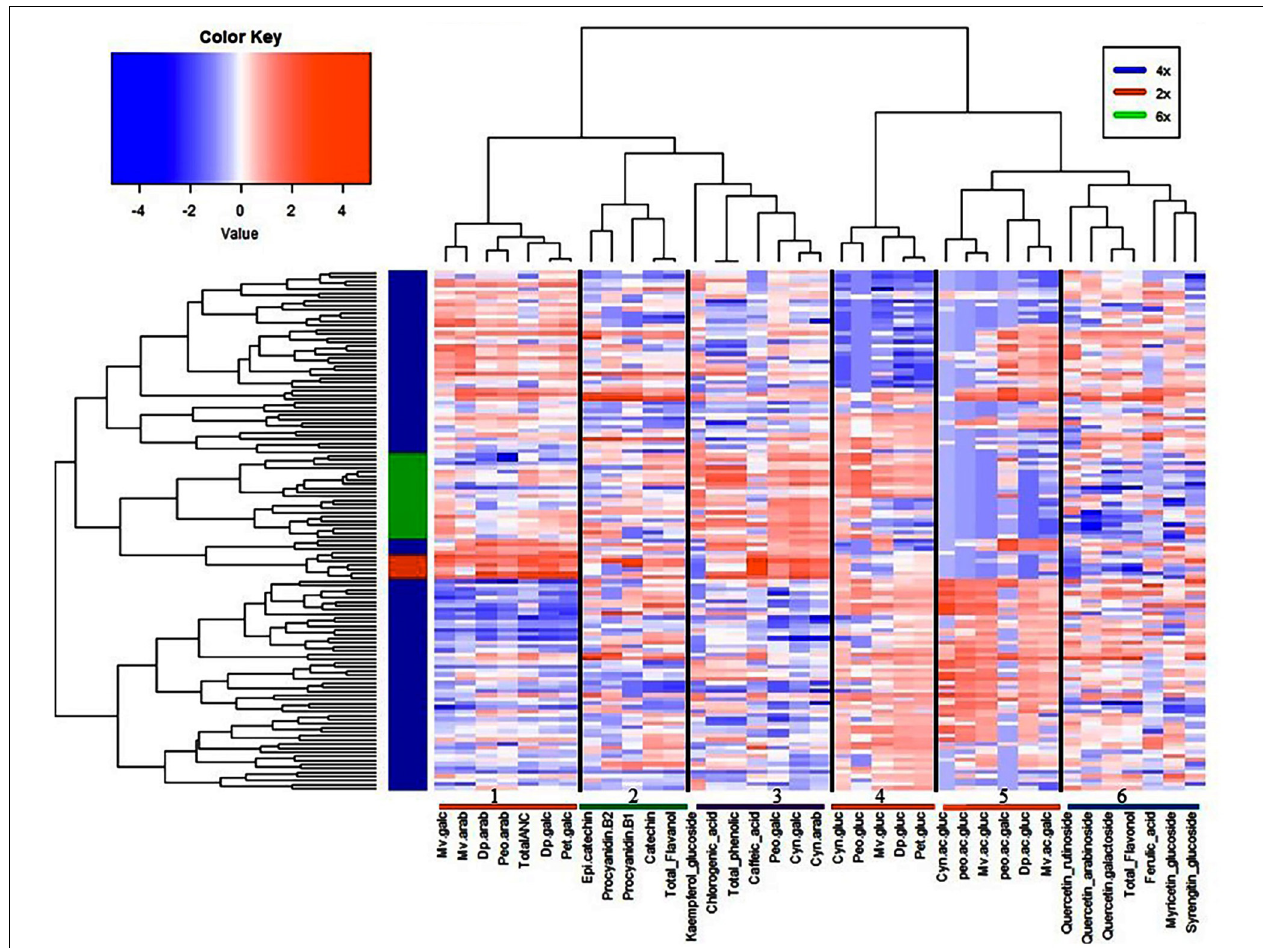
FIGURE 4 | Hierarchical clustering analysis of metabolites and fruit quality traits from all 128 accessions. Six clusters represent the different metabolite classes, anthocyanins (1, 4, 5); flavanols (2); phenolic acids (3); and flavonols